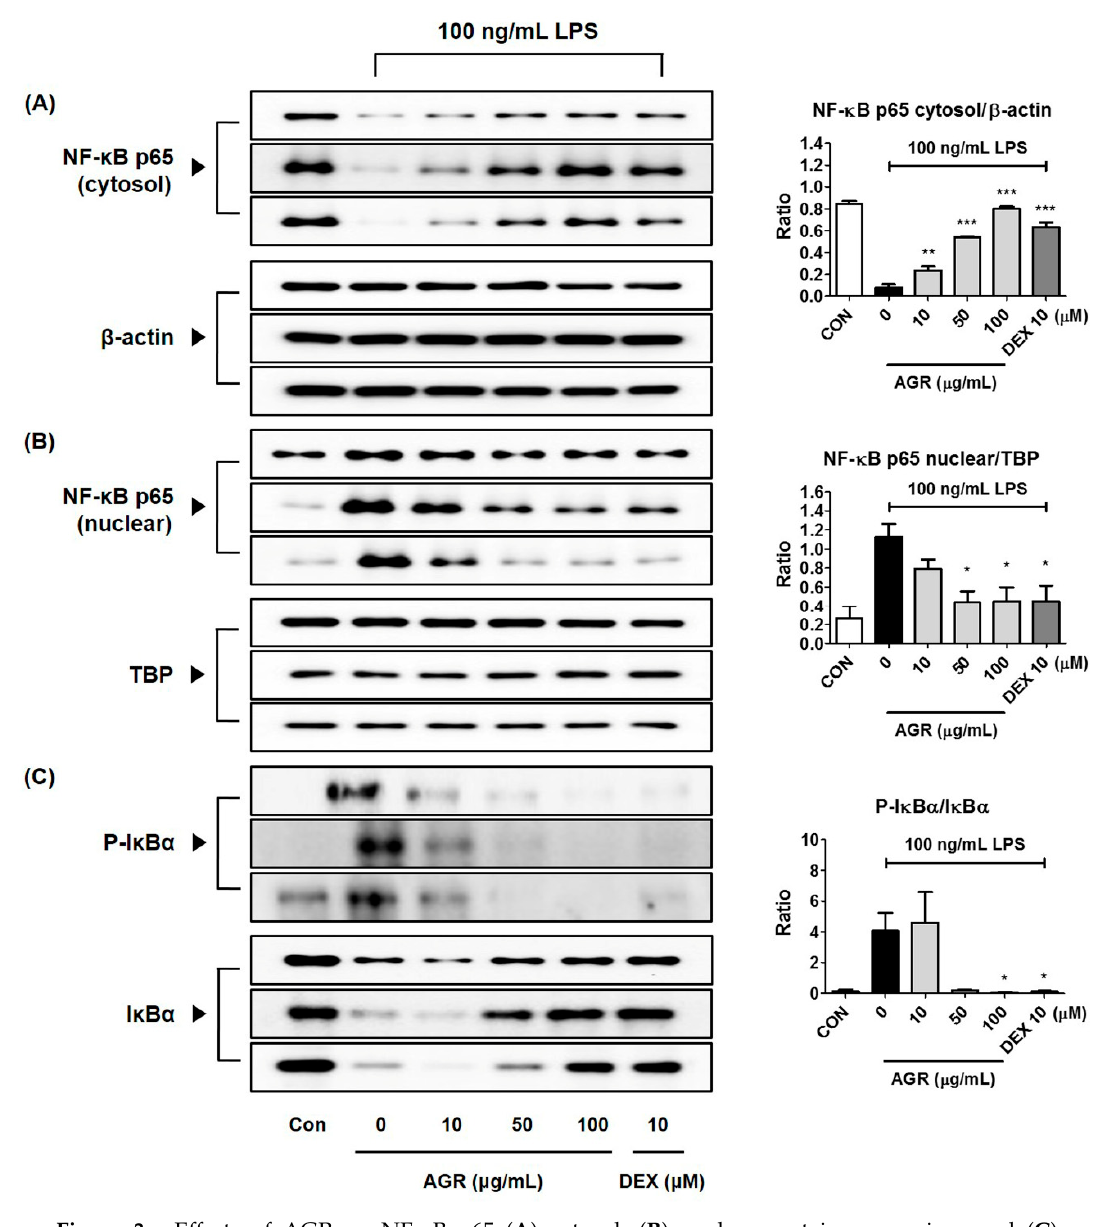
Figure 3. E ff ects of AGR on NF- κ B p65 ( A ) cytosol, ( B ) nuclear protein expression, and ( C ) phosphorylation and degradation of I κ B α . Cells were stimulated with LPS for ( A , B ) 1 h or ( C ) 30 min. The histograms show protein expression levels relative to those of β -actin or TBP. Data represent the mean ± SEM of three independent experiments. * p < 0.05, ** p < 0.001, and *** p < 0.0001 were calculated from comparisons with LPS stimulation values.